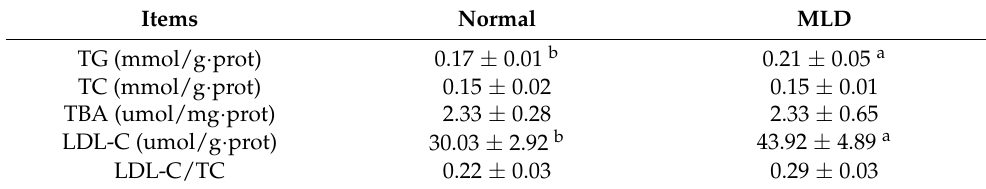
Table 5. Effects of MLD on hepatic lipid metabolism of largemouth bass (means ± SEM).